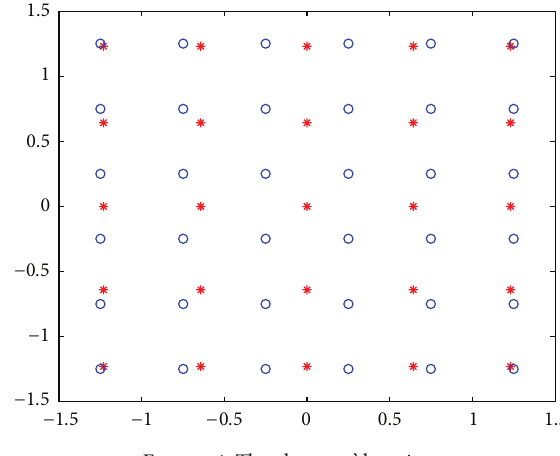
Figure 4: The elements’